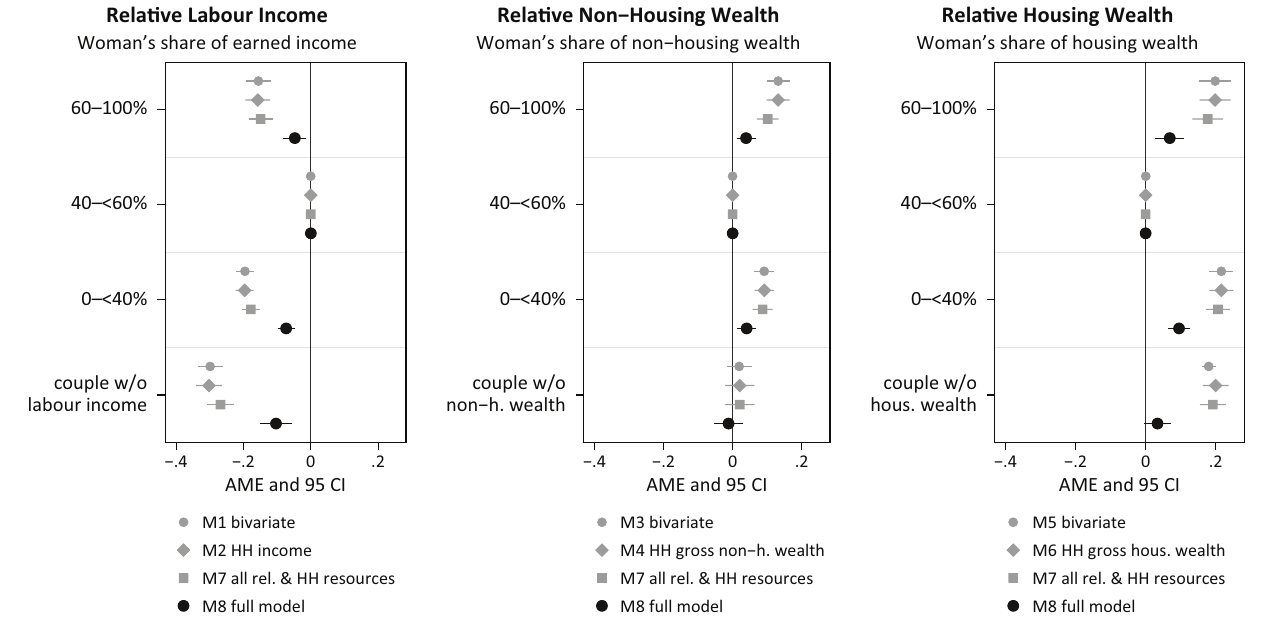
Figure 2. AME for independent money management. Notes: Logistic regression with robust standard errors; controlled for net household income, couple’s total gross non‐housing and housing wealth, total couple debts, marital status, children, couple duration, East German/West German/mixed socialization, woman’s qualification, man’s qualification, man’s age, age difference between partners, survey year; based on SOEP v36; multiply imputed data; unweighted; 𝑁 = 8874